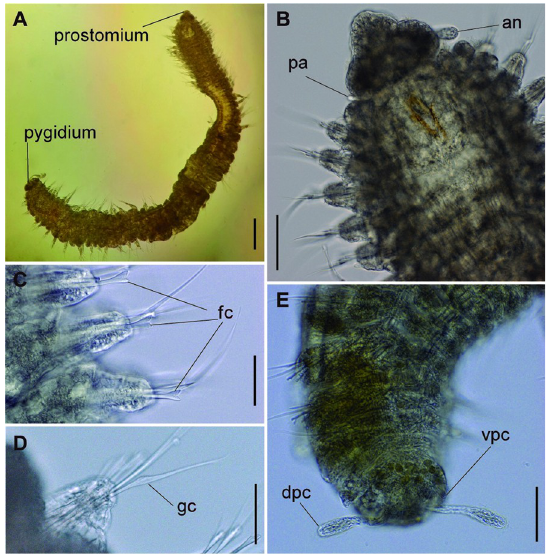
Fig 8. Meiodorvillea penhae sp. nov. (A) complete specimen, dorsal view; (B) anterior region, dorsal view; (C) parapodia from anterior region with furcate chaeta, dorsal view; (D) parapodium from posterior region with geniculate chaeta, dorsal view; (E) pygidial region, ventral view. Abbreviations: an = antenna; dpc = dorsal pygidial cirrus; fc = furcate chaeta; gc = geniculate chaeta; pa = palp; vpc = ventral pygidial cirrus. Scale bars: (A) = 200 μ m; (B,D) = 100 μ m; (C,E) = 50 μ